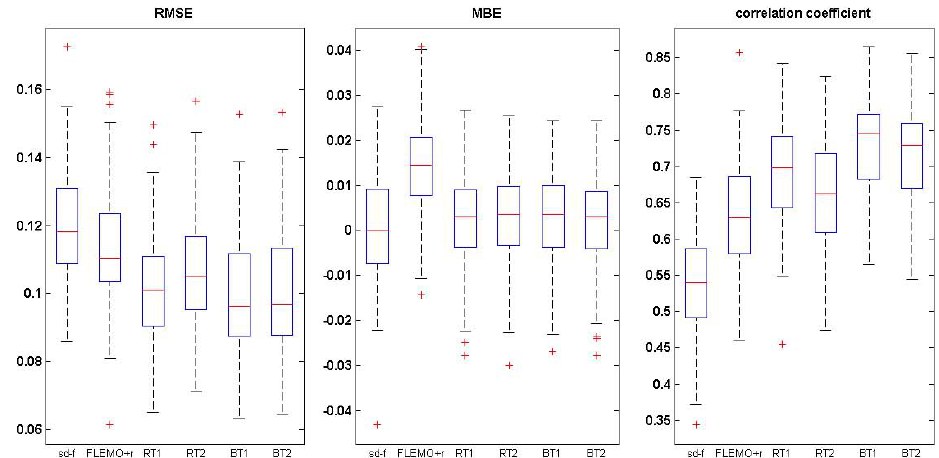
Fig. 7. Comparison of flood damage estimation models (sd-f: stage-damage function; FLEMOps + r; RT1, RT2: regression trees with 25 and 8 leaves, respectively; BT1, BT2: bagging decision trees with 28 and 8 predictors,